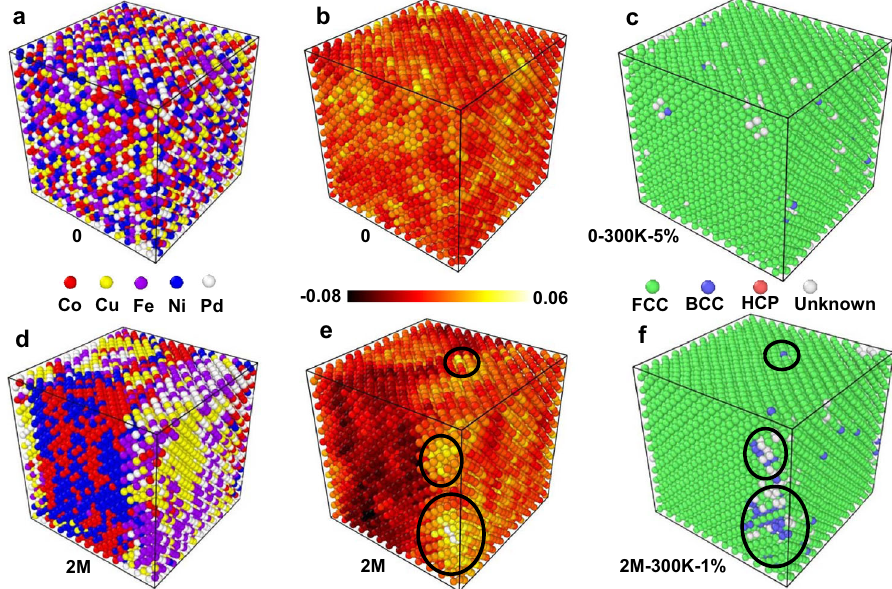
Fig. 3 Atomic con fi gurations, phase stabilities, and local structures of the CoCuFeNiPd HEA with 0 (0 samples) and 2 × 10 6 (2 M sample) iterations at 300 K. Atomic con fi gurations colored according to element type and phase stability ( Δ E FCC-BCC ) for the 0 samples ( a , b ) and the 2 M sample ( d , e ). c The 0 sample after a 5% strain (0-300K-5%), and f the 2 M sample after a 1% strain (2M-300K-1%) during tension at 300